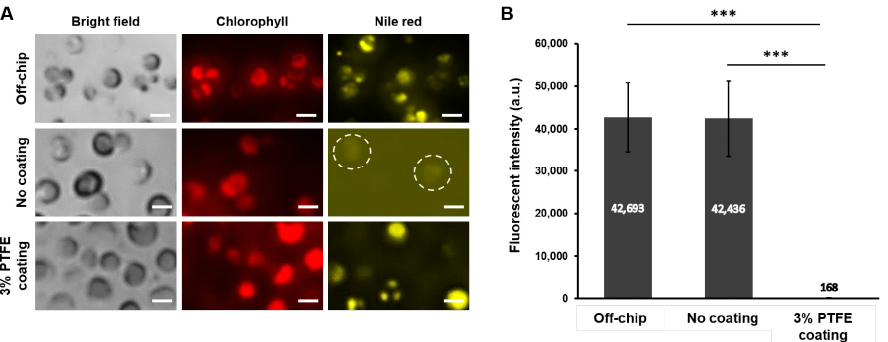
Figure 6. ( A ) Microscope images showing C. reinhardtii CC-125 stained with Nile red (yellow) and Chlorophyll autofluo- rescence (red) for off-chip, PDMS device without coating, and the PDMS device with 3% PTFE coating. Scale bars = 5 μ m. ( B ) Average fluorescent intensity of the stained cells ( n = 10, *** p < 0.001).